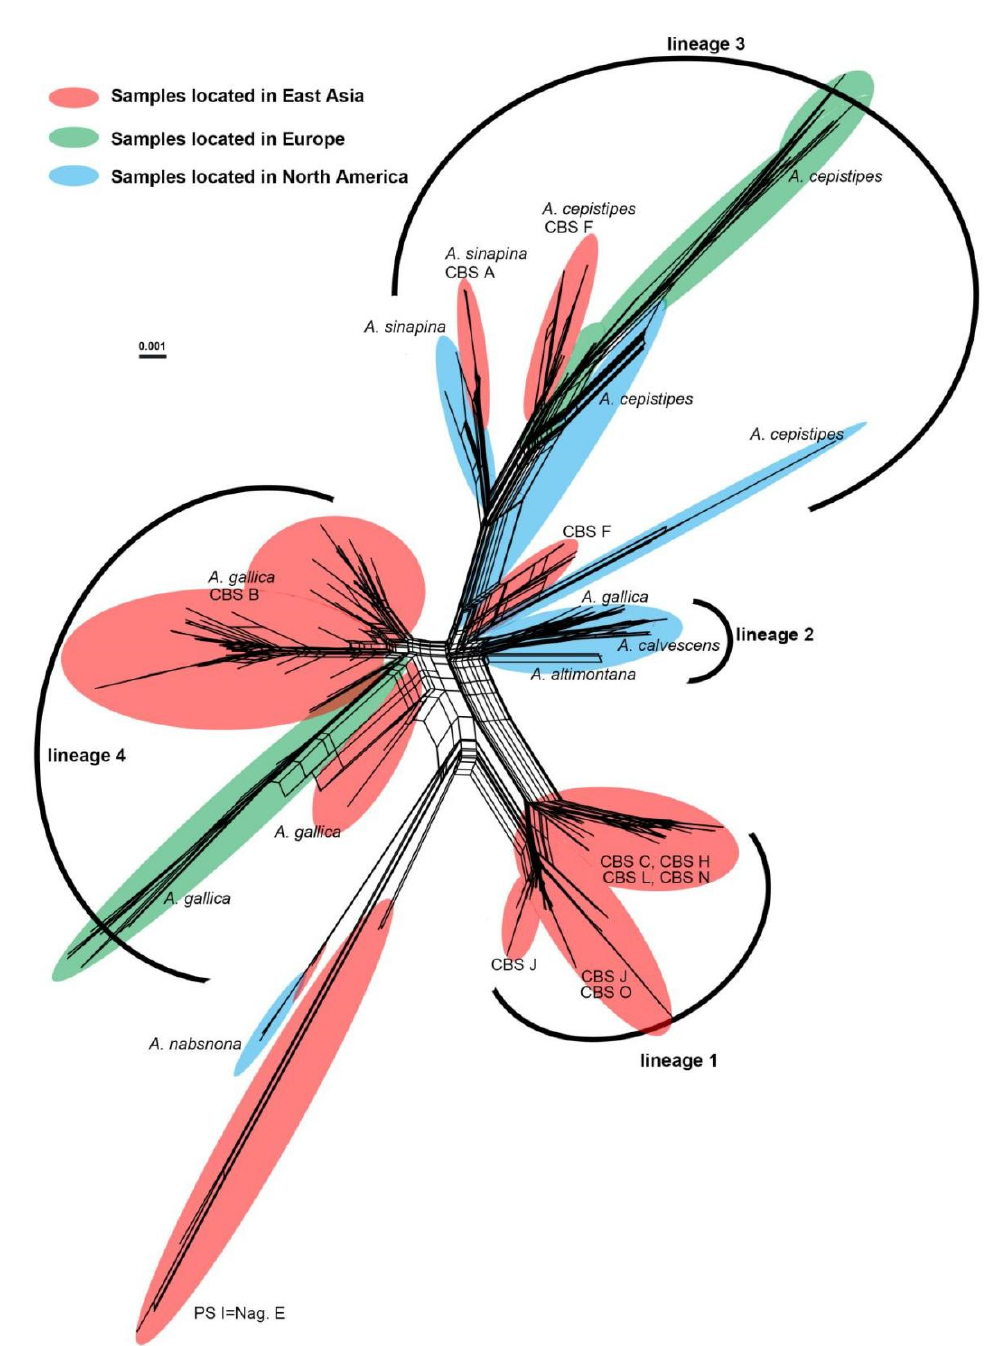
Figure 3. A neighbor-net phylogenetic network based on partial sequences of ITS, IGS-1, and TEF-1 α from 270 Armillaria samples in the Gallica superclade created by SplitsTree v4.14.4 with K2P distance. The names of previously defined species were listed nearby the lineages. Samples located in East Asia, Europe, and North America were highlighted in red, green, and blue, respectively. Detailed information of 270 Armillaria samples is described in Table S1.